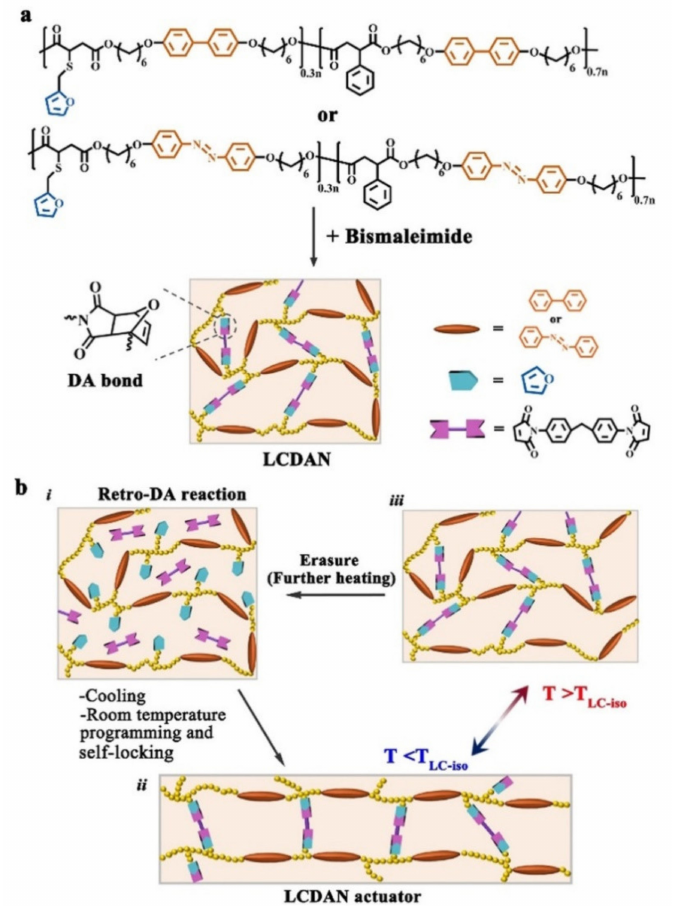
Figure 10. Design of the “self-lockable” LCDAN actuators. ( a ) Chemical structures of two main- chain LCPs bearing furan side groups and containing either biphenyl or azo mesogenic moieties, as well as the preparation of their LCDANs through DA-bonded crosslinking in the presence of bismaleimide. ( b ) A schematic showing the room temperature programming and self-locking of LCDAN actuators capable of reversible shape change upon the LC isotropic (order–disorder) phase transition. Reprinted with permission from Reference [63]. Copyright 2020